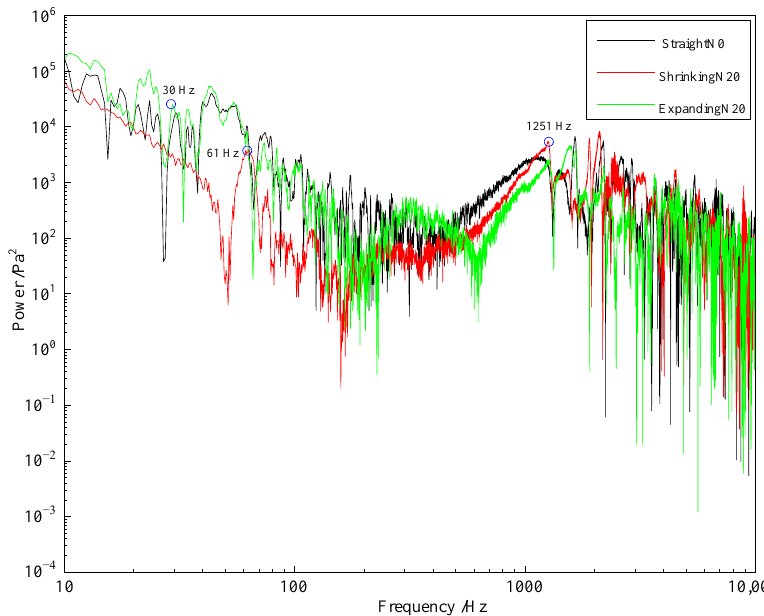
Figure 16. Frequency characteristics of pressure waves when different nozzles were installed.